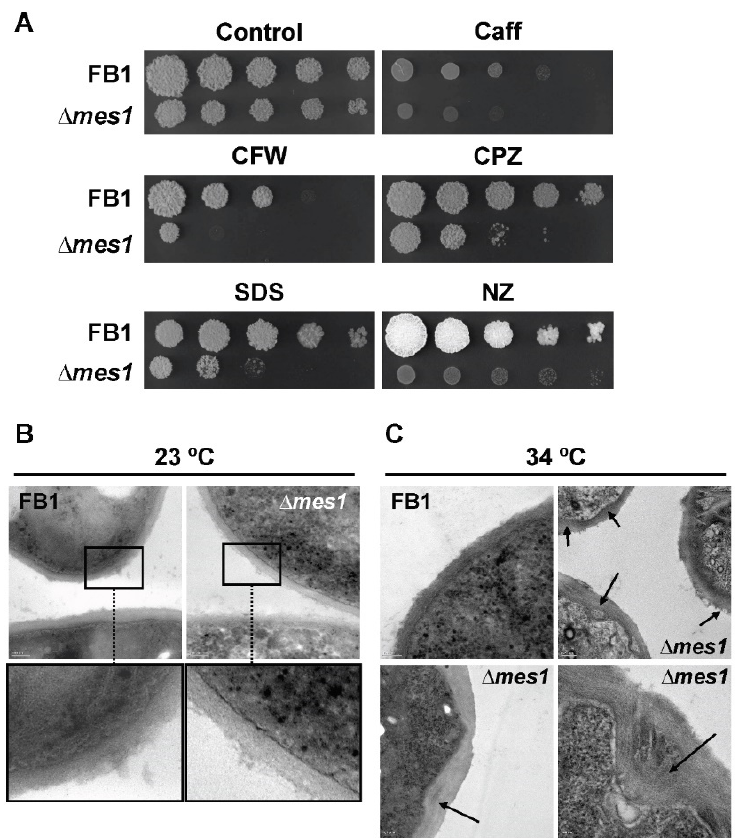
Figure 4. Mes1 is required for cell surface stability. ( A ) ∆ mes1 strain shows increased sensitivity of membrane and cell wall disruptants. Cultures of FB1 and FB1 ∆ mes1 strains were grown to an OD 600 about 1.0 and 10-fold serial dilutions were spotted on YPD plates containing 1.5 mM caffeine (Caff), 50 μ M calcolfluor white (CFW), 50 μ M chlorpromacyn (CPZ), 0.0075% SDS, or 1 μ M Nikkomycin Z (NZ). Plates were incubated at 28 °C and photographed. ( B , C ) TEM of ∆ mes1 strain. FB1 and FB1 ∆ mes1 strain were grown in YPD medium to the exponential phase of growth at room temperature, diluted into fresh YPD medium and grown overnight at 23 °C ( B ) or 34 °C ( C ). Samples were fixed and prepared for TEM. Note that differences were more dramatic at 34 °C. The cell surface of the ∆ mes1 strain appeared as a set of unstructured layers, with frequent invaginations (marked with arrows). Lower panels in ( B ) displayed computer ‐ assisted magnifications of the indicated area.